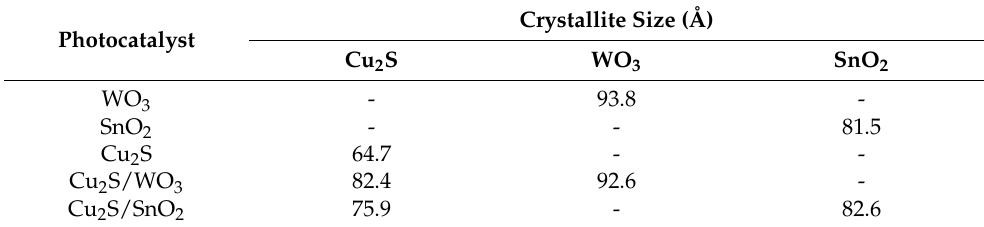
Figure 1. X-ray diffraction (XRD) patterns of the mono-component and heterostructure samples. Table 1. Photocatalysts’ crystallite size values evaluated based on the Scherrer formula.